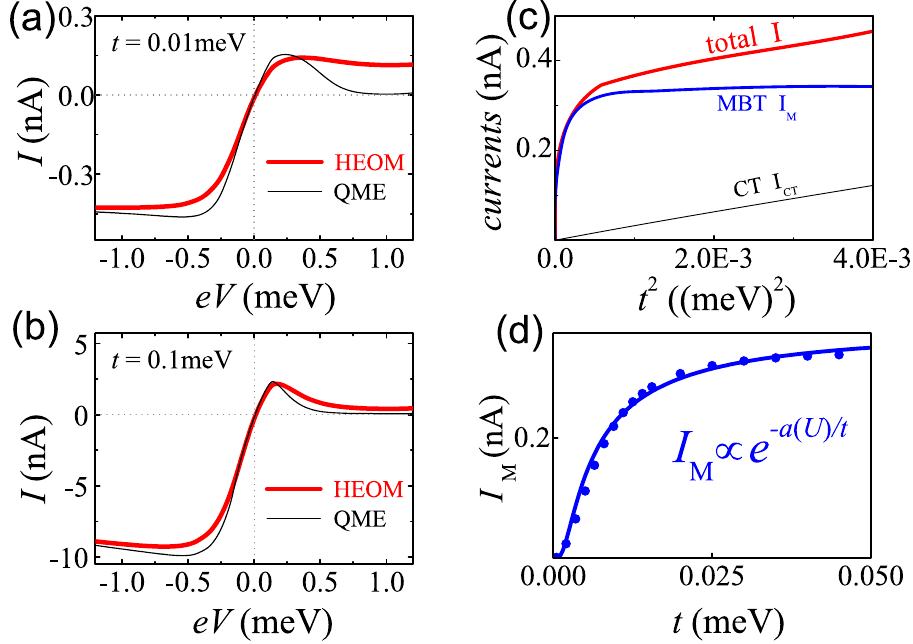
Figure 2. The I – V curves are calculated at t = 0.01 meV in ( a ), and t = 0.1 meV in ( b ), for the DQDs, and U = 2.0 me V fixed. ( c ) The I , I M , and I CT and varying with t 2 are shown at eV = U . ( d ) The dependence of I M on t is given. The dots are numerical data and the solid line is the plot of the function I M ∝ exp[ − α ( U )/ t ] with α ( U ) being a U -dependent